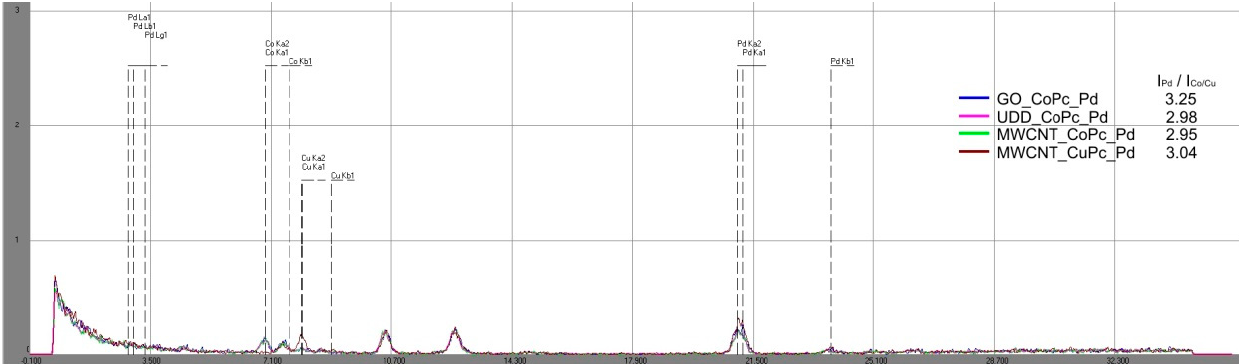
( g ) Figure 3. SEM photographs: ( a ) MWCNT (magnification 5000 times); ( b ) GO; ( c ) UDD; ( d ) MWCNT_C о Pc_Pd (magnification 5000 times); ( e ) MWCNT_CuPc_Pd (magnification 4000 times);